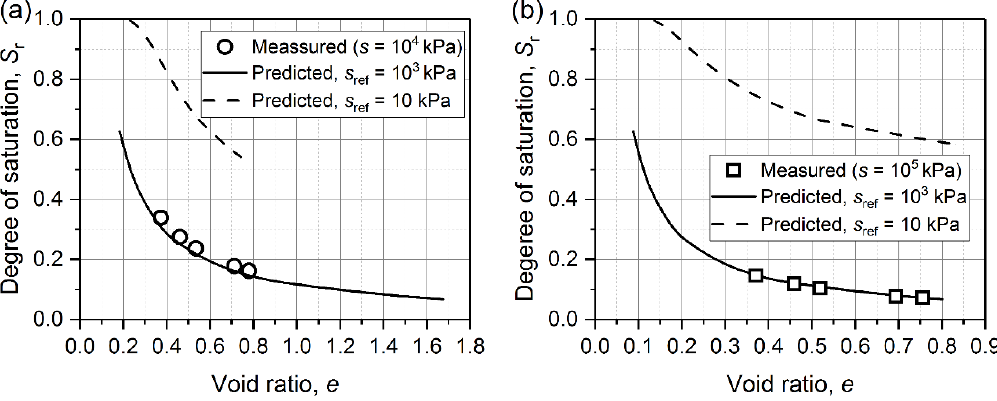
Figure 12. Measured and predicted HMCCs for a silty sand at ( a ) s = 10 4 kPa; ( b ) s = 10 5 kPa.